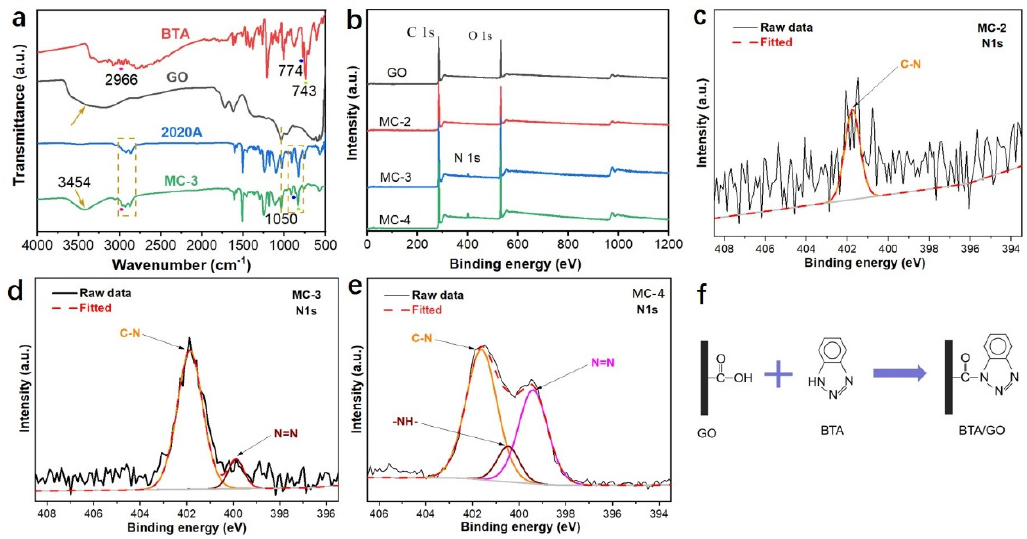
Figure 2. The FTIR ( a ) and XPS ( b ) spectra of the GO microcapsules. High-resolution XPS scans of N1s for MC-2 ( c ), MC-3 ( d ), and MC-4 ( e ). Reaction scheme of GO and BTA ( f ).